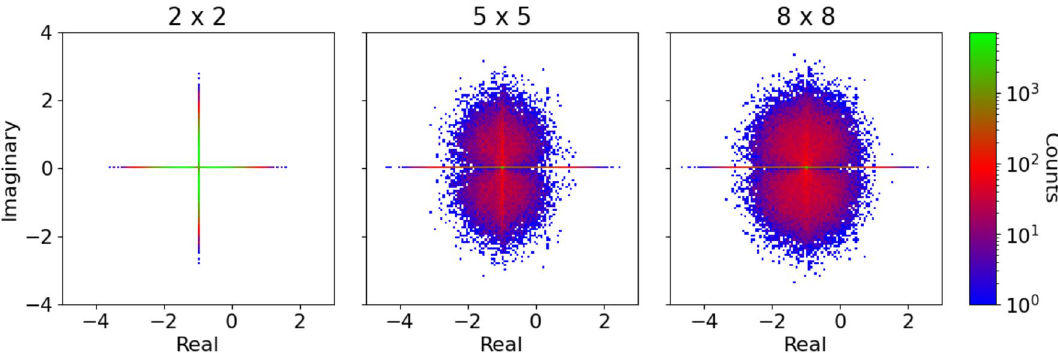
Figure 4. Complex eigenvalue spectra of random matrices. Heat maps of eigenvalue spectra of random matrices, corresponding to the respective species richnesses shown in Fig. 3. Off-diagonal entries are drawn 2 + 21 N − 28 from a normal distribution with probability p ( N ) = N 9 N ( N − 1 ) ( Details : Sec. S5), and are otherwise set to zero. Diagonal elements are set to − 1